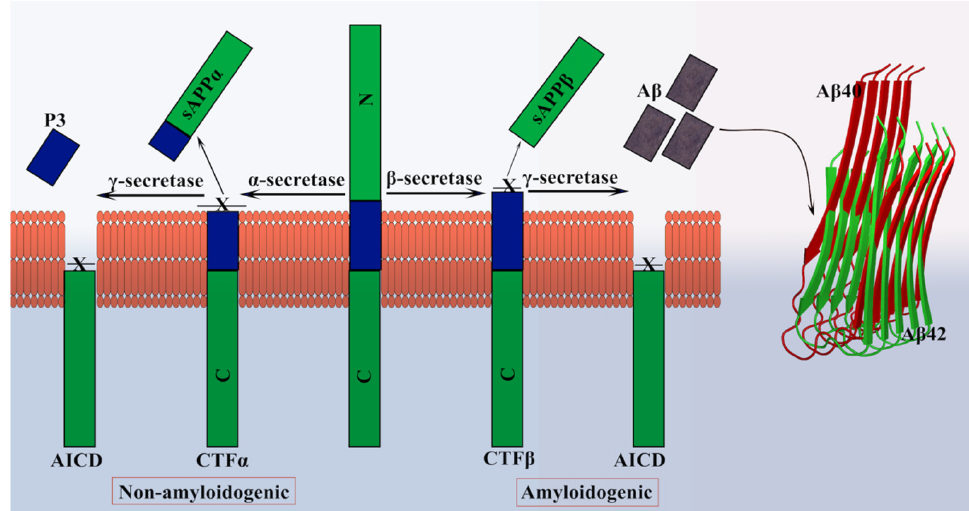
Figure 2. Human APP cleavage pathway. The human APP undergoes proteolytic cleavage in two different pathways: amyloidogenic and non-amyloidogenic. In the non-amyloidogenic pathway, the α -secretases cleave within the A β domain to form the α -C terminal fragments (CTF α ), and the N-terminal soluble APP (sAPP α ). The CTF α is subsequently cleaved by γ -secretase to form P3 and APP intracellular domain (AICD). In the amyloidogenic pathway, the β -secretase initially cleaves APP to form β -C-terminal fragments (CTF β ) and N-terminal-soluble APP (sAPP β ). The CTF β is then cleaved by γ -secretase to form extracellular A β and AICD. The arrangement of A β 40 (red) (PDB ID: 6TI5) [65] and A β 42 (green) (PDB ID: 2BEG) [66] in the fibrillar phase are shown on the right. The β -sheet structure of the peptide and the parallel direction can be observed in the figure.